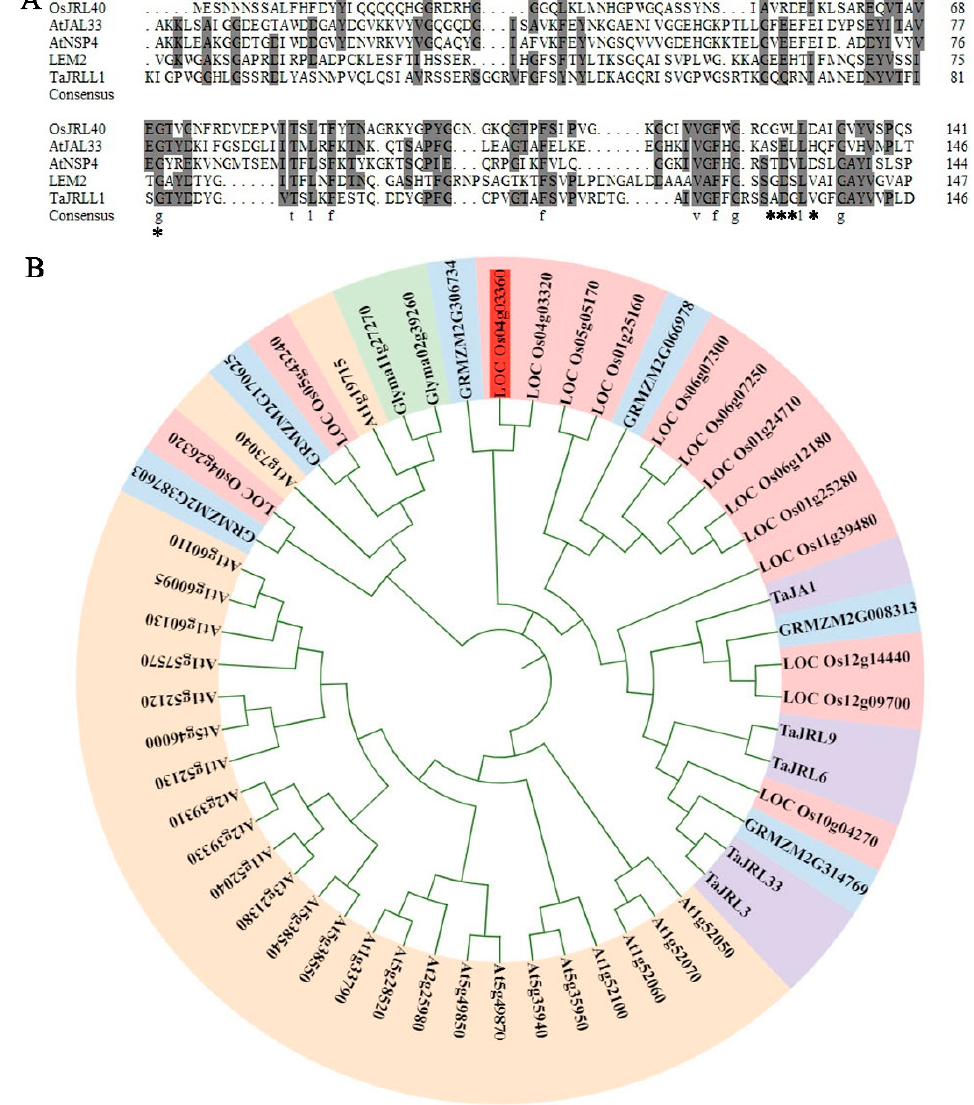
Figure 1. Analysis of OsJRL40 amino acid sequence and phylogenetic relationship. ( A ) Amino acid sequence alignment of OsJRL40, barley LEM2 (AAM18206), TaJRLL1 (ADP37001), AtJRL33 (NP_001030711), and AtNSP4 (NP_188262). Dark shading indicates conserved residues, and invariant residues are marked with lowercase letters. Asterisks indicate mannose-binding sites in the Heltuba protein. ‘*’ represents the mannose-binding site. ( B ) Analysis of the evolutionary relationship between OsJRL40 and JRLs in other species (rice, Arabidopsis, wheat, maize, and soybean). The phylogenetic tree was constructed using the neighbor-joining method in MEGA 7.